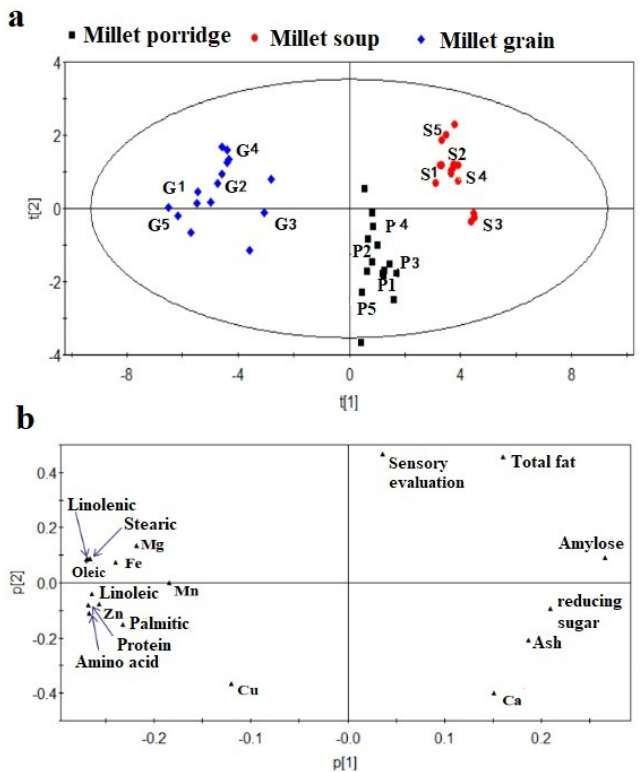
Figure 1. Principal component analysis (PCA) of millet porridge cooked in different electric cookers: ( a ) PCA score diagram; ( b ) PCA load diagram.